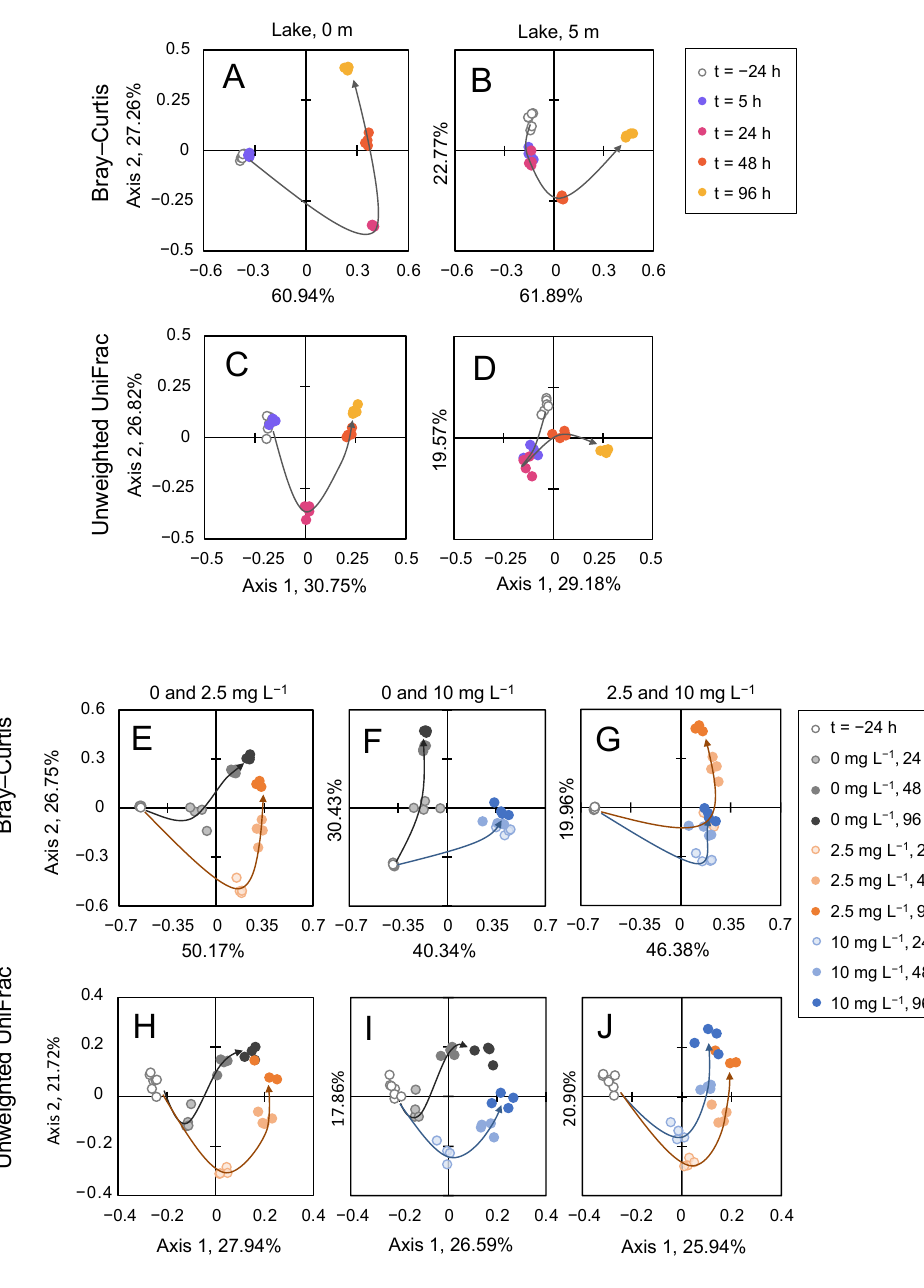
Figure 8. Beta diversity of the microbial community during the H 2 O 2 treatment in August. PCoA plots of beta diversity of the microbial community during ( A – D ) the lake treatment and ( E – J ) the incubation experiments in August. Beta diversity in ( A , B ) and ( E – G ) is based on the Bray–Curtis dissimilarity matrix, in ( C , D ) and ( H – J )—on the unweighted UniFrac distance matrix. Each symbol in the graph represents one sample; all samples with symbols of the same color are biological replicates. Gray open circles represent samples in the lake prior to the H 2 O 2 treatment (i.e., the starting community at t = − 24 h). Arrows visualize the trajectories of the bacterial communities throughout the experiment. Pairwise PERMANOVAs revealed significant differences between all clusters within the same